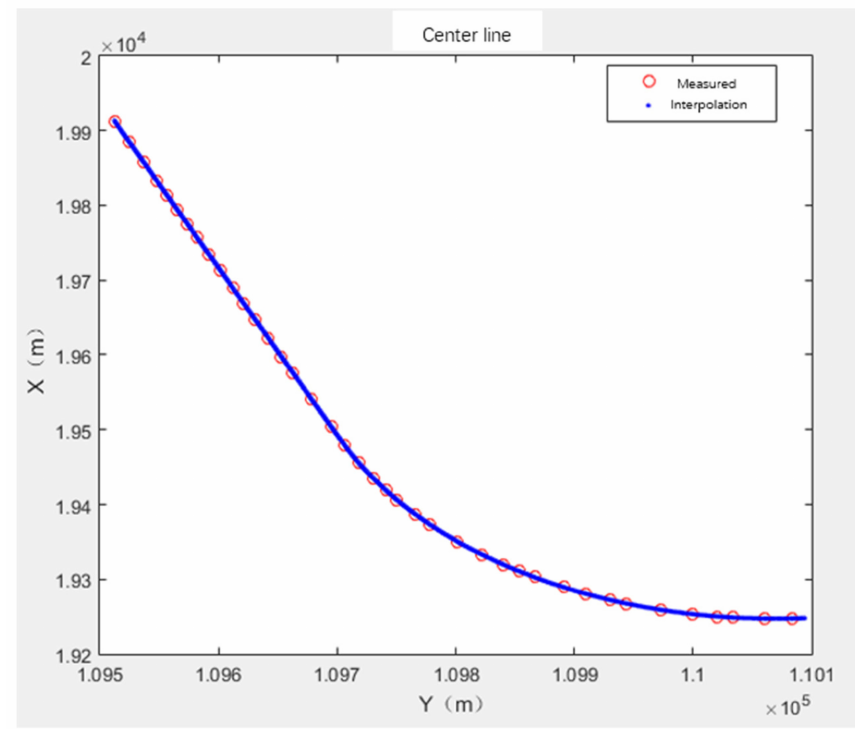
Figure 3. Interpolation center line of measured